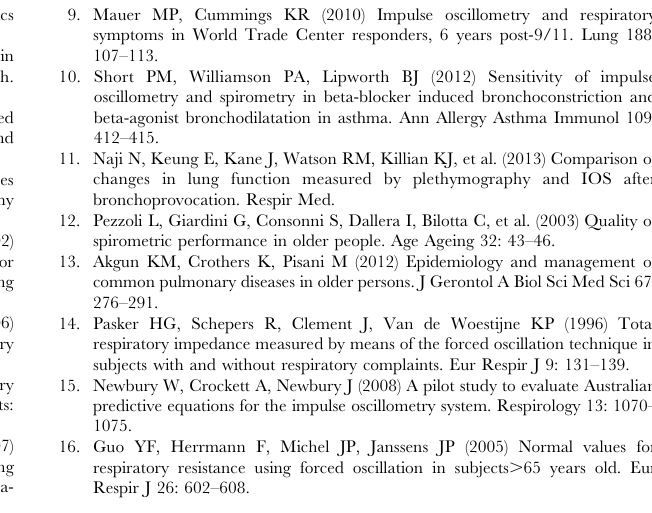
Figure S1 Frequency dependency of resistance and reactance. Resistance and reactance between 5 Hz and 35 Hz of the lung healthy study population is provided for men (n= 154) and women (n= 243). # indicate significant differences between men and women (p , 0.05) (TIF) Figure S2 Age dependency of IOS indices. Individual values of men and women are provided for different IOS indices. Further, the median (solid), 5th (dotted) and 95th (dashed) percentile of a subject with median height and weight values of our study population is shown. (TIF) Table S1 Reference equations of IOS indices for men and women. Provided are quantile regression equations for the IOS indices R10, R15, R25, R35, and X10 to X35 for